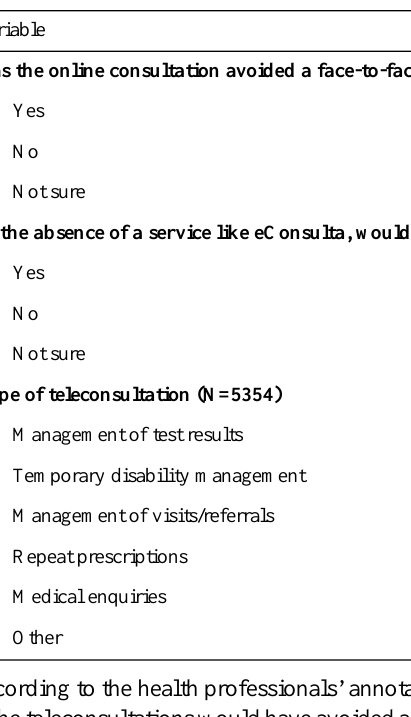
In the absence of a service like eConsulta, would